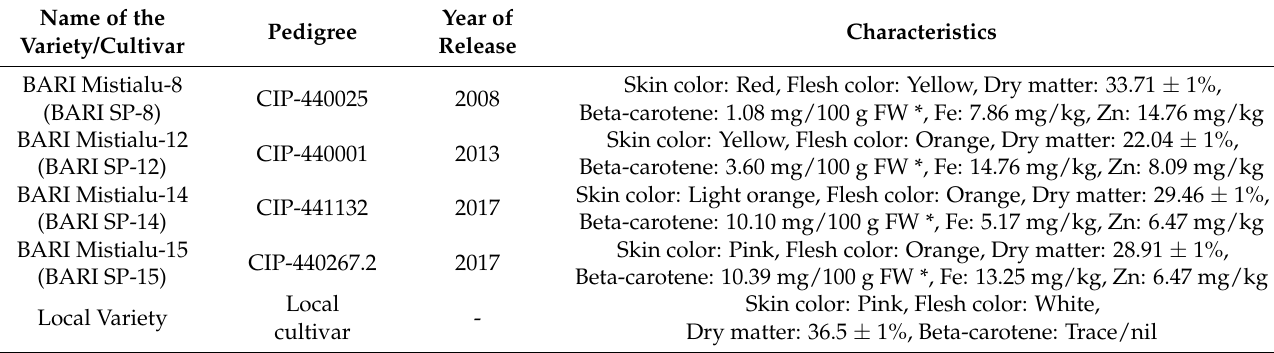
Table 2. Major Characteristics and year release of OFSP varieties used in the trial during both crop seasons. Name of the Skin color: Red, Flesh color: Yellow, Dry matter: 33.71 ± 1%,